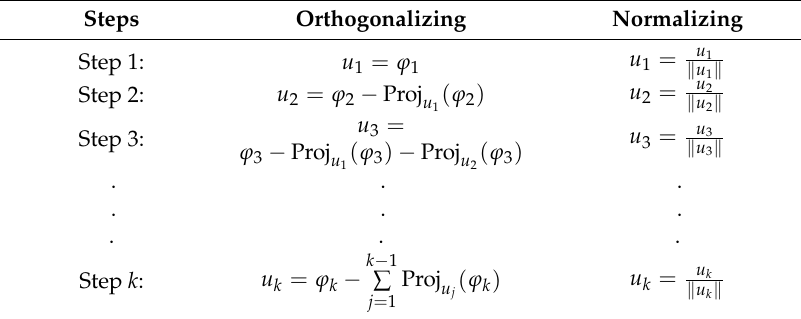
Table 1. Steps of the Gram-Schmidt